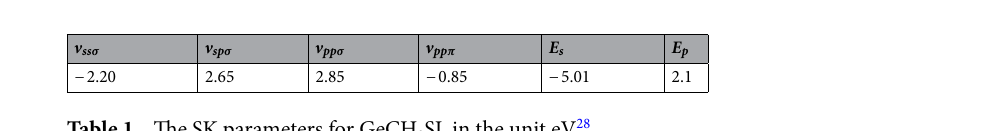
Table 1. The SK parameters for GeCH 3 SL in the unit eV 28